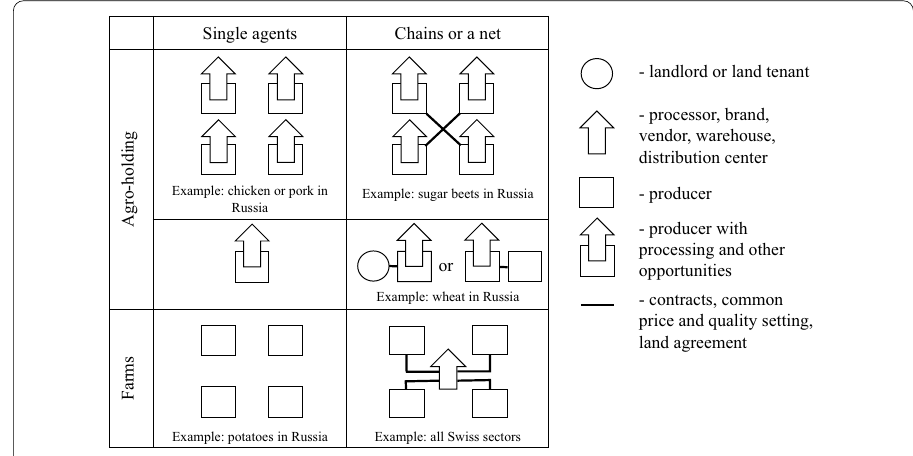
Fig. 2 Structure of agricultural sectors classified for dummy